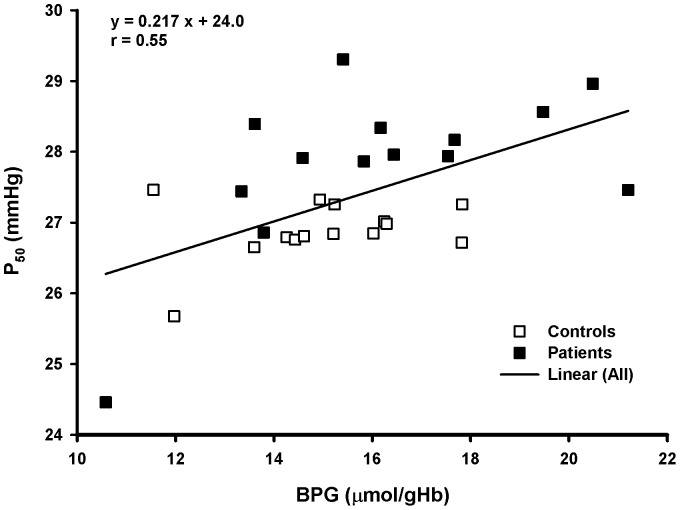
Dependence of P50st on BPG concentration (means of equilibrated samples).Regression line for all values, correlation coefficient r different from zero (P<0.01).